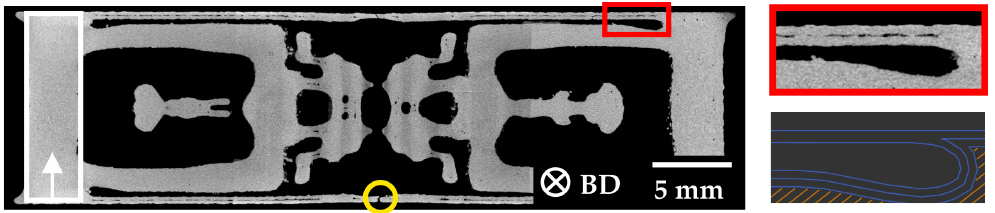
Figure 21. Single slice image of the manufactured design proposal for optimization case 1 of the developed optimization